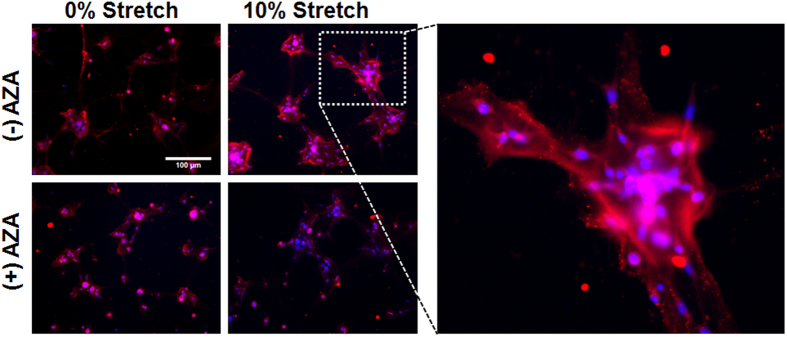
Expression and Localization of AQP4.Representative immunostains of AQP4 expression on C8D1A cells in our in vitro model. The cropped and enlarged image on the right shows the localization of the AQP4 expression to the perimeter of the C8D1A cell clusters (endfeet localization).